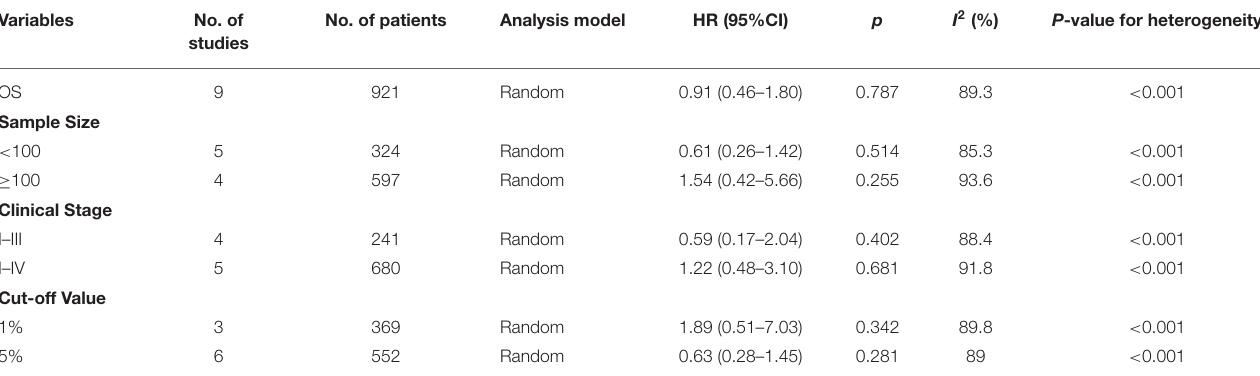
TABLE 3 | Subgroup analysis of the association between PD-L1 expression and OS in SCLC.